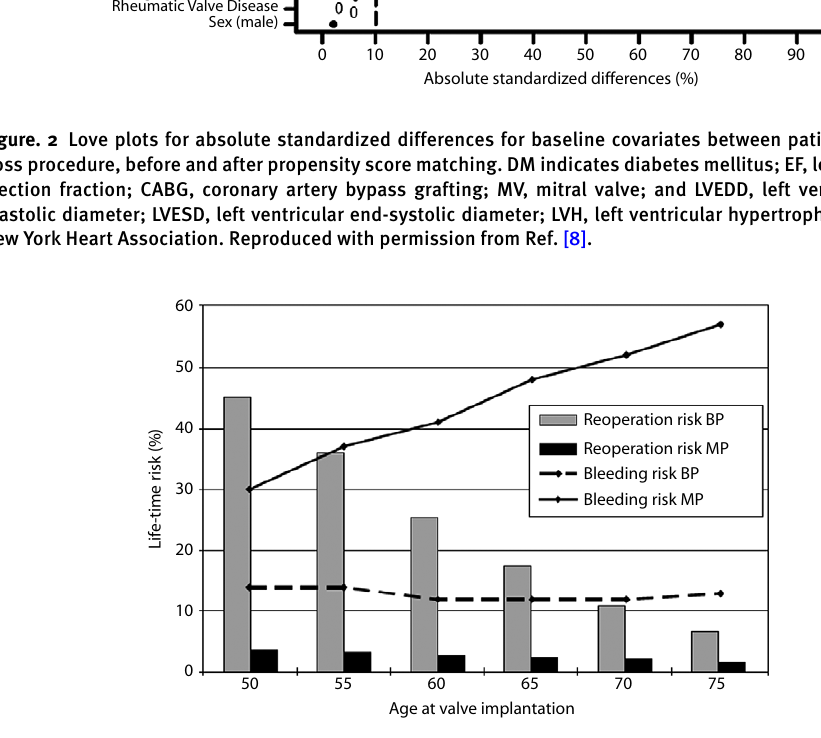
Figure. 3 Lifetime risks of reoperation and bleeding after AVR with mechanical and bioprostheses. BP, bioprosthesis; MP, mechanical prosthesis. Reproduced with permission from Ref. [10]. changing patient population of more and more elderly patients with multiple co-morbidities, with mortality risks that continue to decrease. Decreased mortality is a blessing for our patients, but represents a growing challenge for statisticians to accurately predict early outcome based on the characteristics of our patients. We need to rebalance our outcome analysis efforts and besides looking for new explanatory variables that may help us build better models and surrogate outcomes that attempt to reflect quality, also focus on forensic analyses through critical appraisal of the journey of each patient through our hospitals, as Dr de Leval nicely describes in his reflections on outcome analyses [12]. In this respect we can learn a lot from the aviation industry where checklists have proven to be